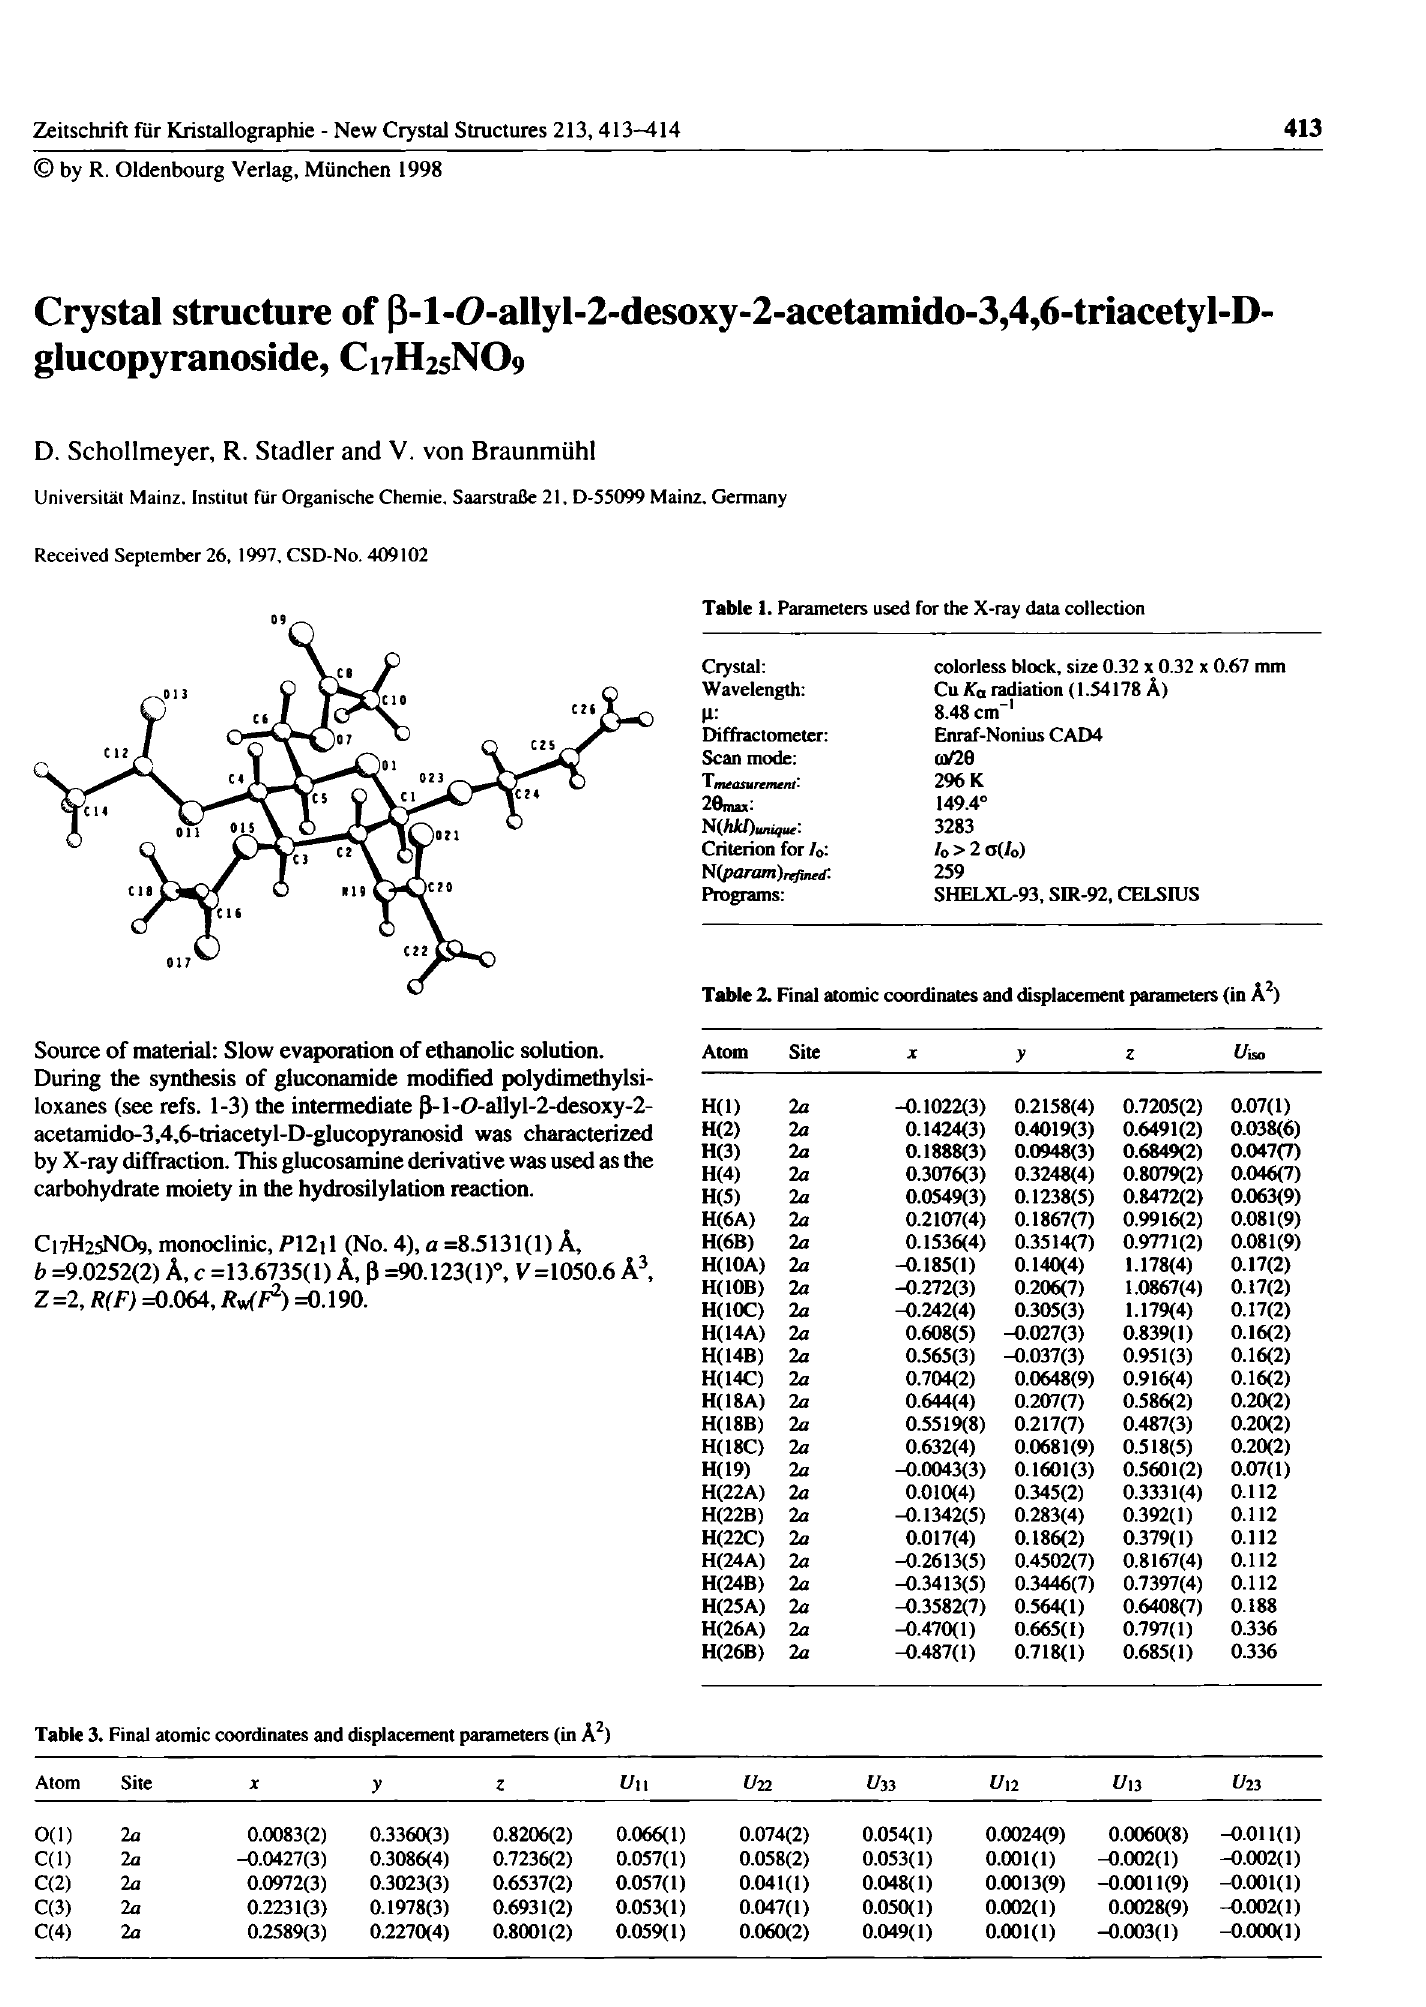
Table 3. Final atomic coordinates and displacement parameters (in Â^)